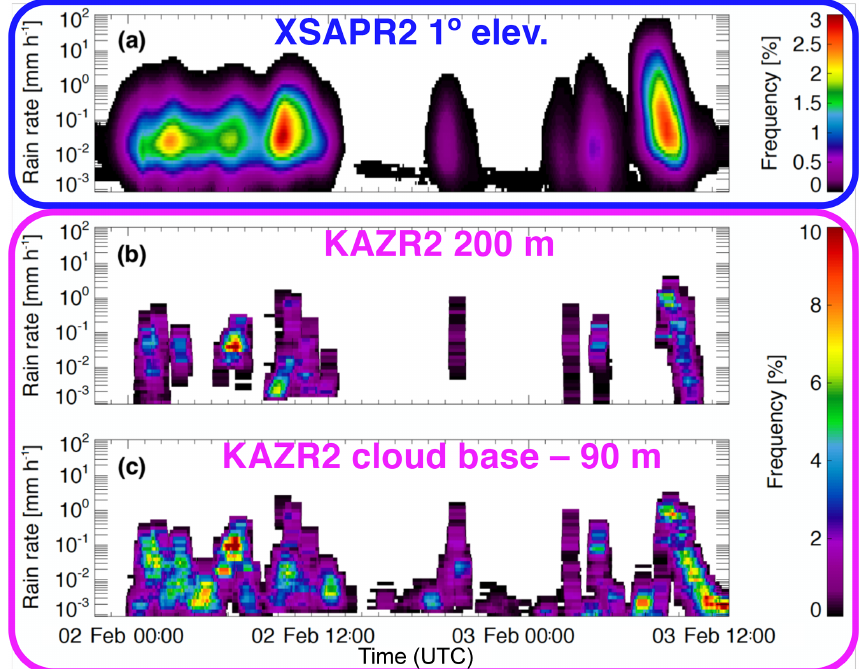
Figure 9. For a 36h period (00:00UTC, 2 February, to 12:00UTC, 3 February), hourly probability density functions (pdfs) of precipitation rate are presented, estimated from (a) XSARP2 when performing a 1 ◦ elevation PPI scan, (b) KAZR2 200m from the surface, and (c) KAZR2 90m below cloud base height.